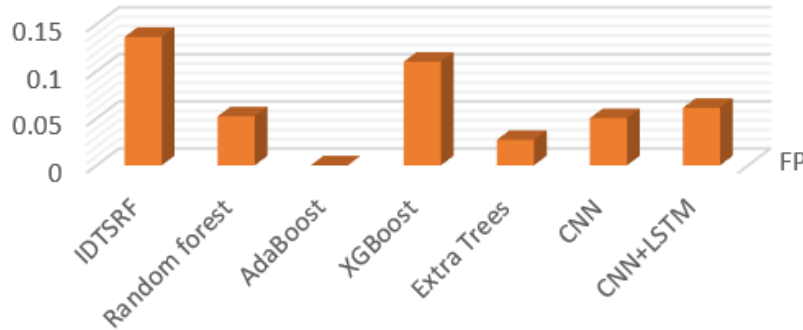
Figure 11. FP Comparison chart.